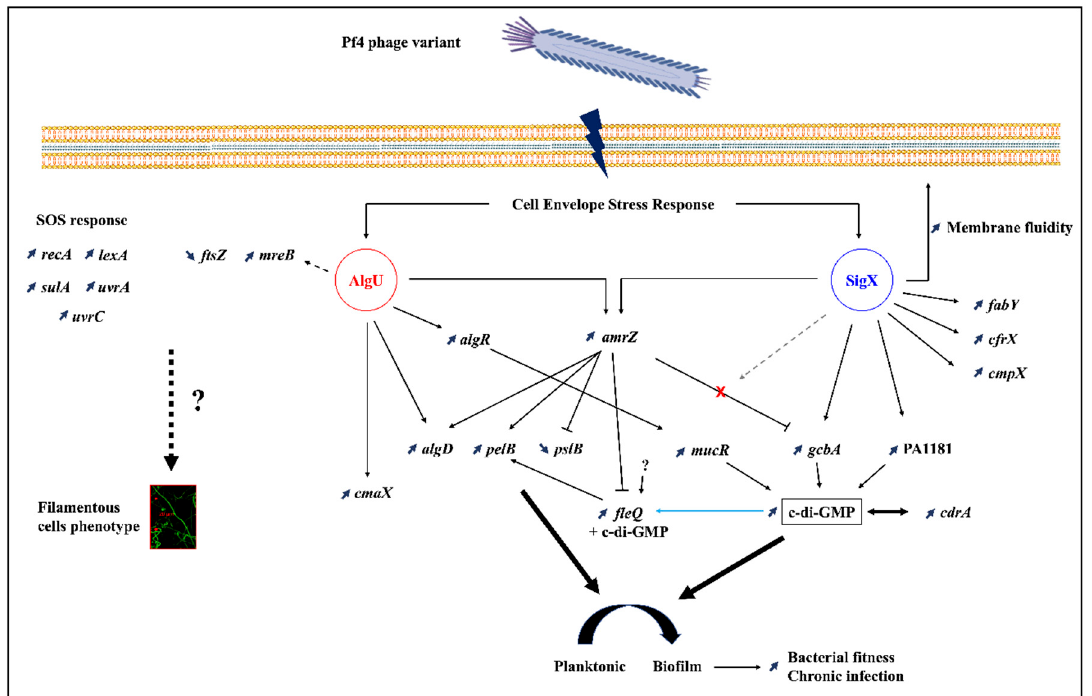
Figure 7. Pf4 phage variant infection altered P. aeruginosa H103 regulatory circuits and physiology. P. aeruginosa H103 infection by Pf4 phage variant leads to a SigX and AlgU-mediated cell envelope stress response. The activation of the SigX extracytoplasmic function sigma (ECF σ ) factor triggers increased membrane fluidity and increased gene expression of gcbA and PA1181 diguanylate cyclases, most likely responsible of the c-di-GMP-increased concentration. The AlgU activation leads to increased algR expression, whose products are responsible for mucR increase, encoding another diguanylate cyclase. The ECF σ factors AlgU and SigX modulate amrZ expression, which in turn controls exopolysaccharide gene expression. The increased c-di-GMP concentration (according to cdrA gene expression) and exopolysaccharides lead to a switch from planktonic to sessile lifestyles. The increased of mreB expression and the induction of the SOS response could be responsible for the observed filamentation phenotype. Thin black full arrows or broken lines represent direct transcriptional regulation. Thin blue full arrow indicates a direct regulation, but not at the transcriptional level. Thin grey arrow represents the possible bypass of SigX in gcbA transcriptional AmrZ-dependent regulation. Thin dashed arrow represents potential regulation. Figure S1. Sequence of the whole Pf4* prophage variant from dH103Pf4 + strain (PA0715–PA0729). Figure S2. SOS response induction after Pf4 phage variant infection. Figure S3. ∆ sigX and ∆ algU mutants are resistant to Pf4 phage variant infection. Figure S4. Cell envelope stress response is not induced by LUZ19 phage TFP-mediated infection. Table S1. Strains used in this study. Table S2. Primers used in this study. Table S3. SNPs and deletion identified in PA0724 protein sequence from dH103Pf4 + strain.